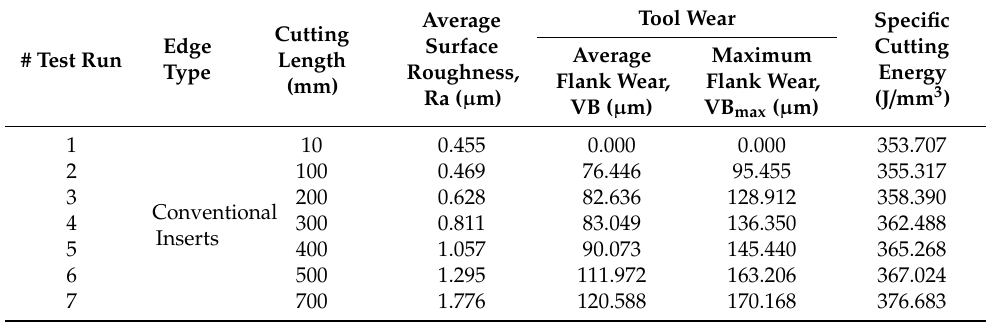
Table 4. Progressive surface roughness, tool flank wear, and specific cutting energy for the